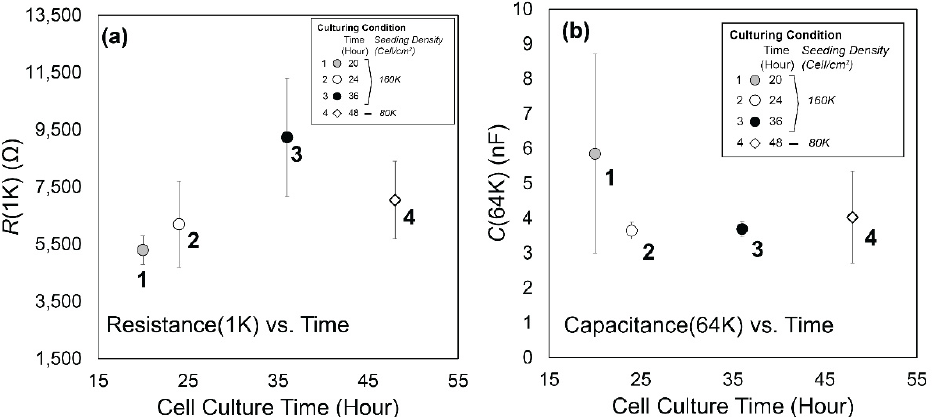
Figure 7. ( a ) R (1K) and ( b ) C (64K) comparisons of four H441 confluent layers having different cell–cell tight junction density generated by using different culture times and seeding densities. Error bars represent standard deviation of data from the nodes ( n = 7 or 8) in the flow chamber.